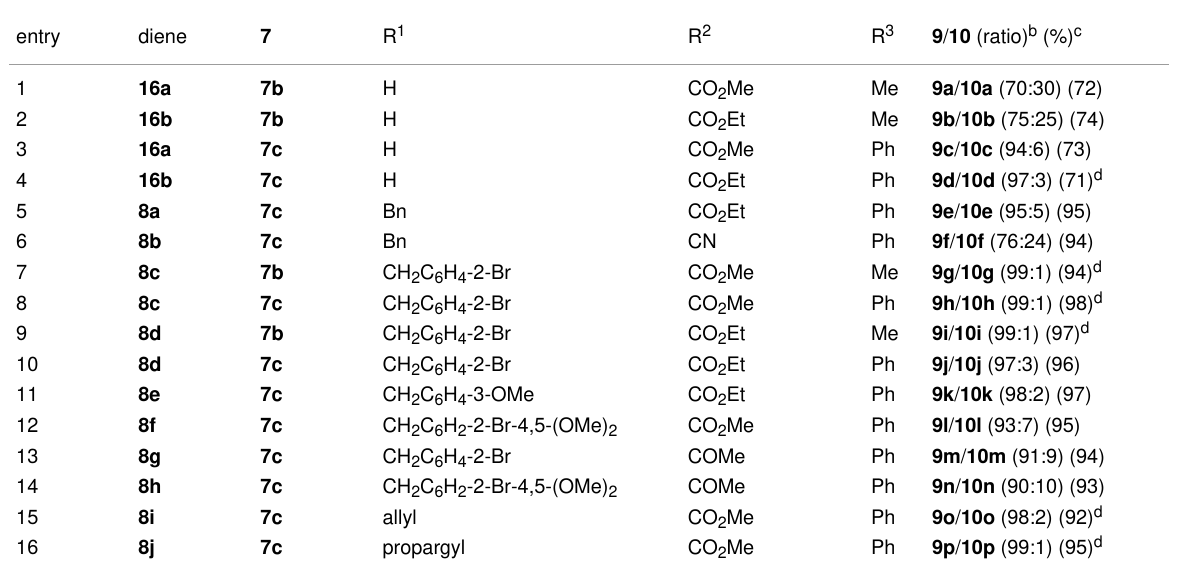
Table 2: Diels–Alder reactions of 2-vinylpyrroles 8a – j and 16a , b with maleimides 7b , c . a